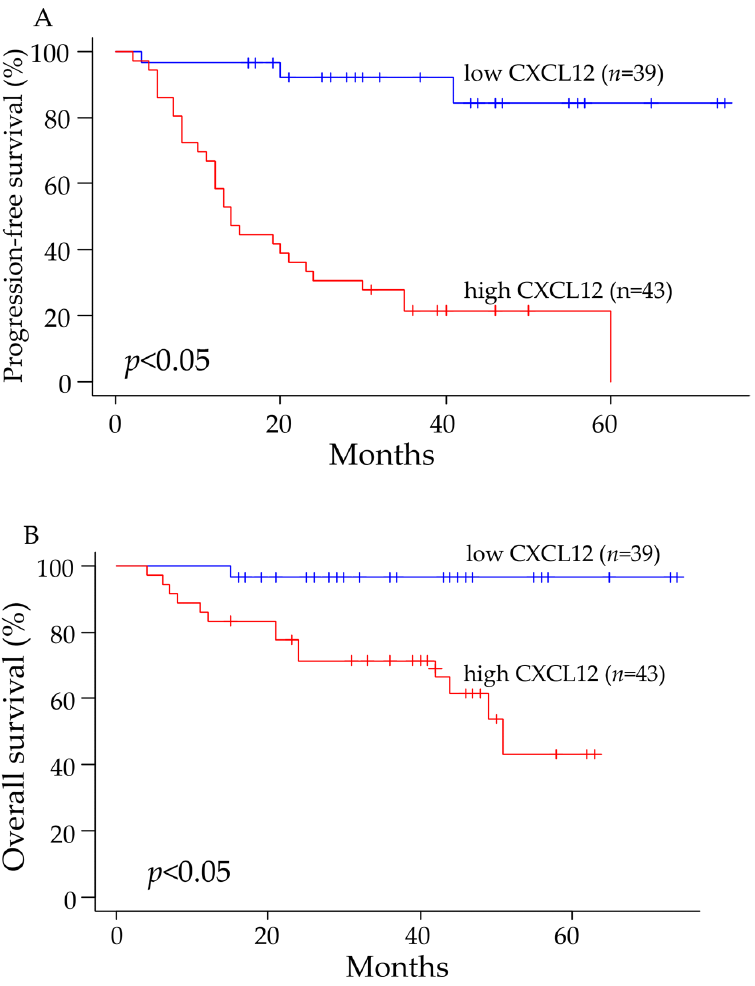
Figure 3. The progression-free survival and overall survival were significantly better in patients with tumors showing low expression of CXCL12. The progression-free survival ( A ) and overall survival ( B ) are illustrated using the Kaplan–Meier method.